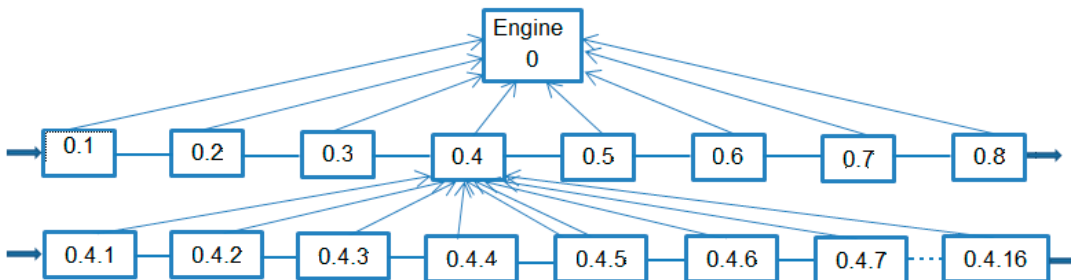
Figure 2. Fragment of the block diagram of the hierarchical decomposition of the marine combustion engine intended fuelled with distillate fuels: 0—engine level, 0.1—engine block, 0.2—piston-crank system, 0.3—exchanges of the working medium system, 0.4—fuel feed system, 0.4.1—settling tank, 0.4.2—transport pump, 0.4.3—filter of the transport pump, 0.4.4—fuel service tank, 0.4.5—centrifuge filter, 0.4.6—fuel centrifuge, 0.4.7—strainer fuel filter, 0.4.8—fine filter, 0.4.9—booster fuel pump, 0.4.10—injection pump, 0.4.11—injection pipe, 0.4.12—injector, ..., 0.4.16—check valve, 0.5—lubrication system, 0.6—cooling system, 0.7—starting system, 0.8—automatic steering and control system.